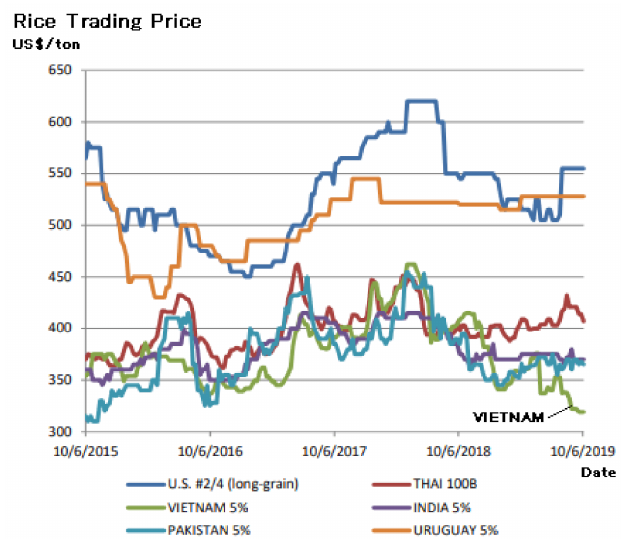
Figure 1. Rice Trading Prices of major rice exporting countries from 2015 to 2019. Vietnamese rice price is always close to the bottom level. Source: created from the data of the United States Department of Agriculture (USDA)